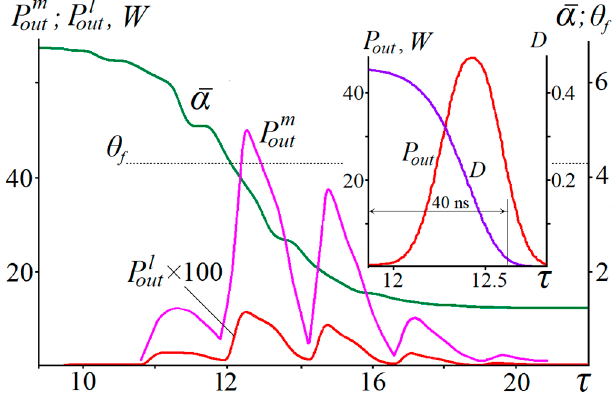
Figure 8. A single generation pulse that occurs at the Q-factor decline in the AOM with three ports. Inset: the output pulse that occurs when the AOM is turned off at the time τ m = τ 0 + 12.5 τ and time dependence of D ( τ ).